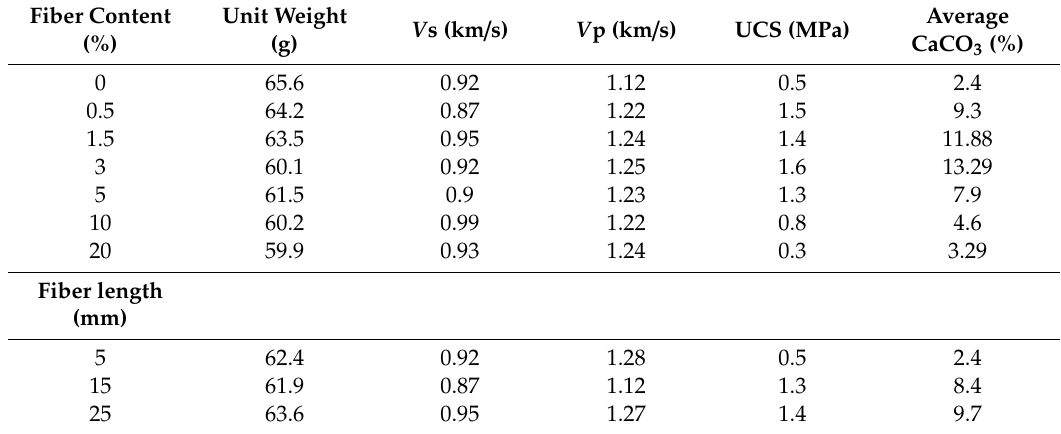
Table 6. Summary of test results for the biocemented sand after MICP treatment with jute fibers. Fiber